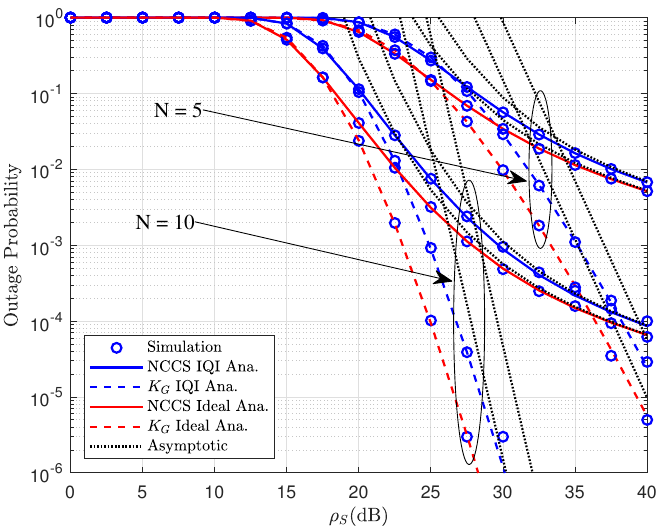
Figure 4. The outage probability vs. ρ S (dB) with varying N for RIS-DH case.